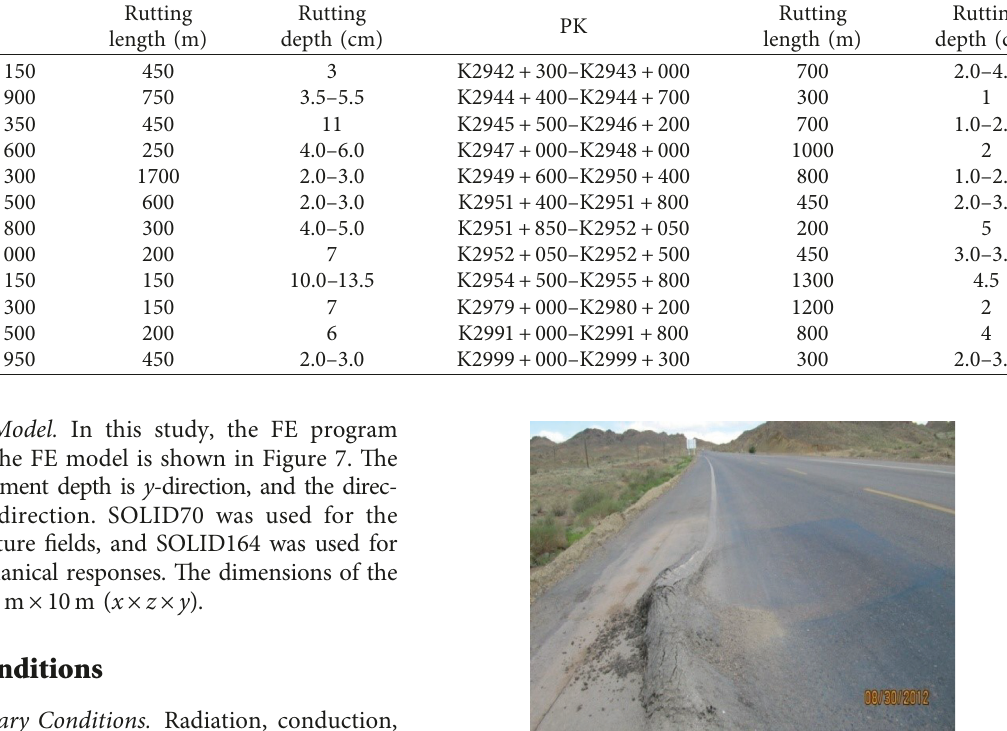
Table 1: Investigation of rutting in southern Xinjiang in national highway no. 30 (Kumul Section). PK